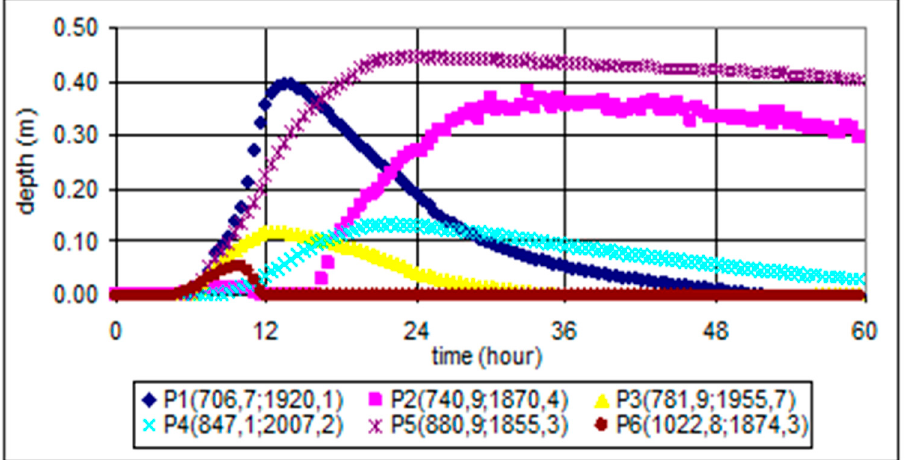
Figure 9. Temporal changes of flood depths for the pixels P1–P6.